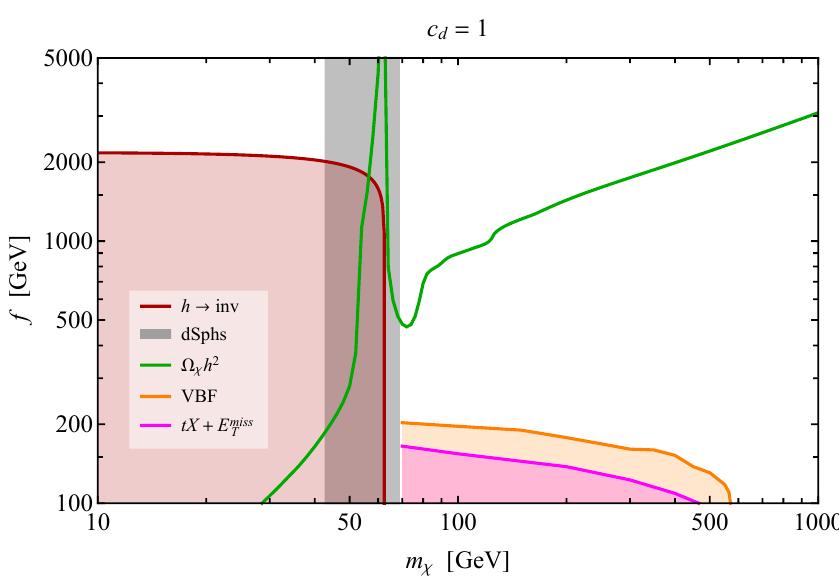
Figure 6 . Constraints in the m χ – f plane for the derivative Higgs portal model. The pNGB DM effective field theory parameters not shown in the headline of the plot are set to zero to obtain the displayed results. The dark red region is excluded by the projected HL-LHC 95% CL limit on the Higgs invisible branching ratio of BR ( h → inv) < 2 . 5 · 10 − 2 [90]. The vertical grey band displays the DM mass range that is excluded at 95% CL by the dSphs analysis of Fermi-LAT and DES [111] assuming χ ∗ χ → b ¯ b annihilation. The green curve corresponds to the value Ω χ h 2 = 0 . 12 of the DM relic density as determined by PLANCK [110]. In the parameter space above the green curves the Universe is overclosed. The orange region indicates the 95% CL exclusion limit derived in [25] from a study of off-shell invisible Higgs production in the VBF channel at the HL-LHC, while the magenta region represents the corresponding exclusion limit obtained by our tX + E miss